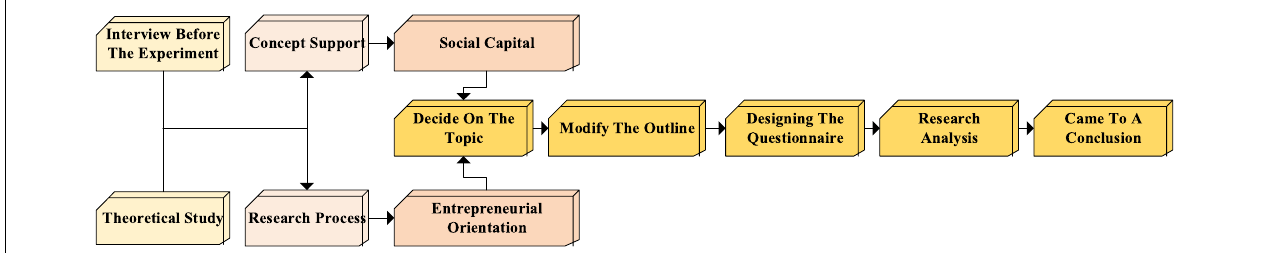
FIGURE 6 | Technical roadmap of the questionnaire.